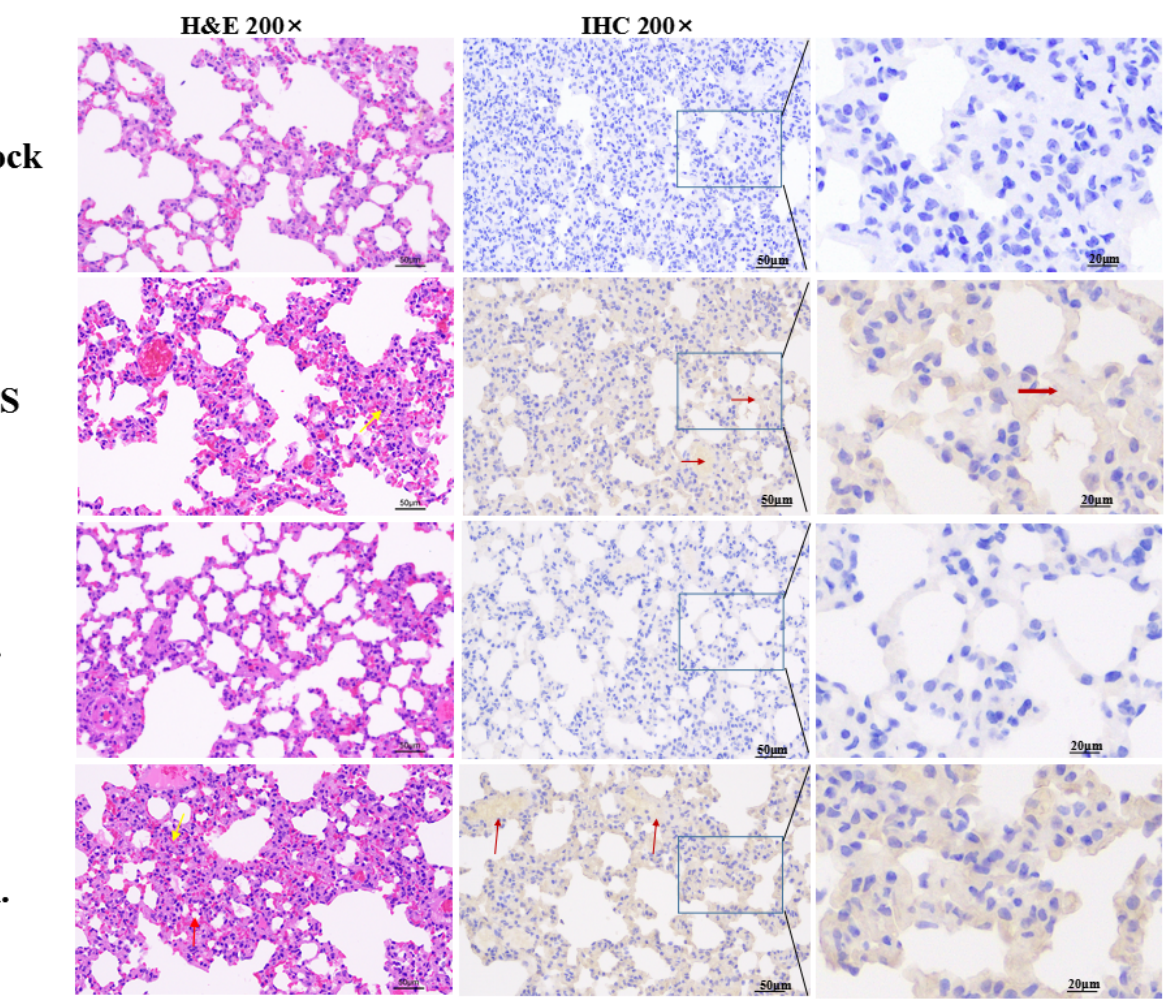
Figure 5. Representative H&E staining and IHC of lung sections from SARS-CoV-2-infected golden hamsters at 3 days post-infection. Mock refers to hamsters inoculated with PBS and free from SARS- CoV-2 challenged. i.m., i.n. and control refer to i.m. inoculation group, i.n. inoculation group and PBS inoculation group who were challenged with SARS-CoV-2, respectively. In H&E staining sections, the thickened alveolar wall and proliferated epithelial cells are marked with yellow arrows, broken alveolar diaphragms and atrophic alveoli are marked with red arrows. In IHC sections, SARS-CoV-2 antigens that were recognized by SARS-CoV-2-N-specific antibodies were marked with red arrows.